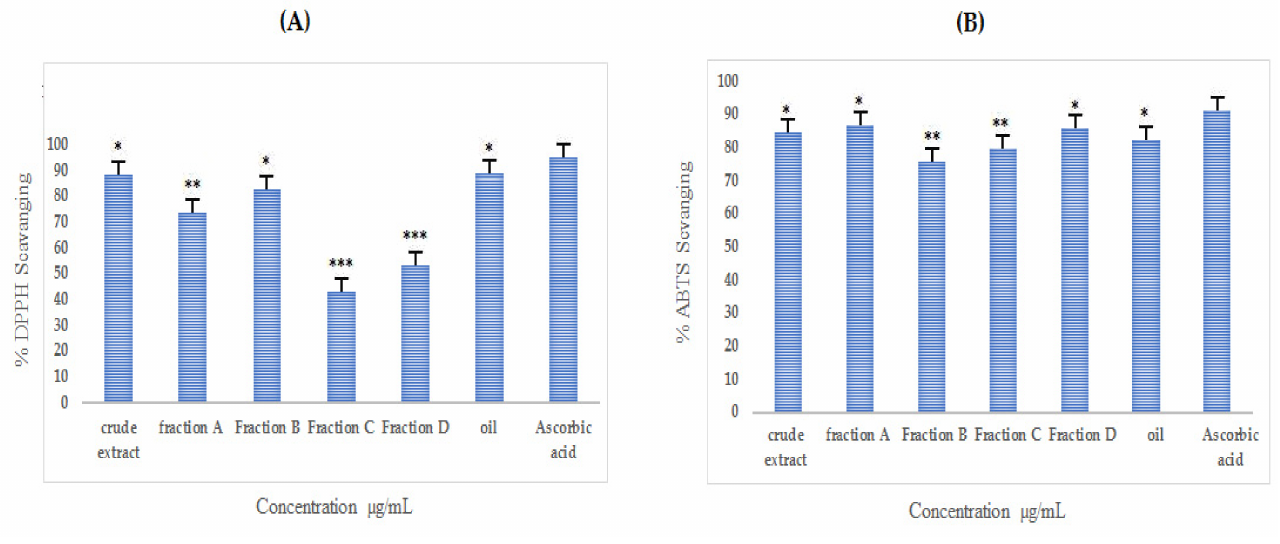
Figure 7. Antioxidant activity (( A ) = DPPH; ( B ) = ABTS) of crude extract, purified fractions (A, B, C, and D), and oil fraction of A. articulata . The data plotted is mean ± SEM, n = 3. Values are significantly different as compared to positive control * p < 0.05, ** p < 0.01, *** p <